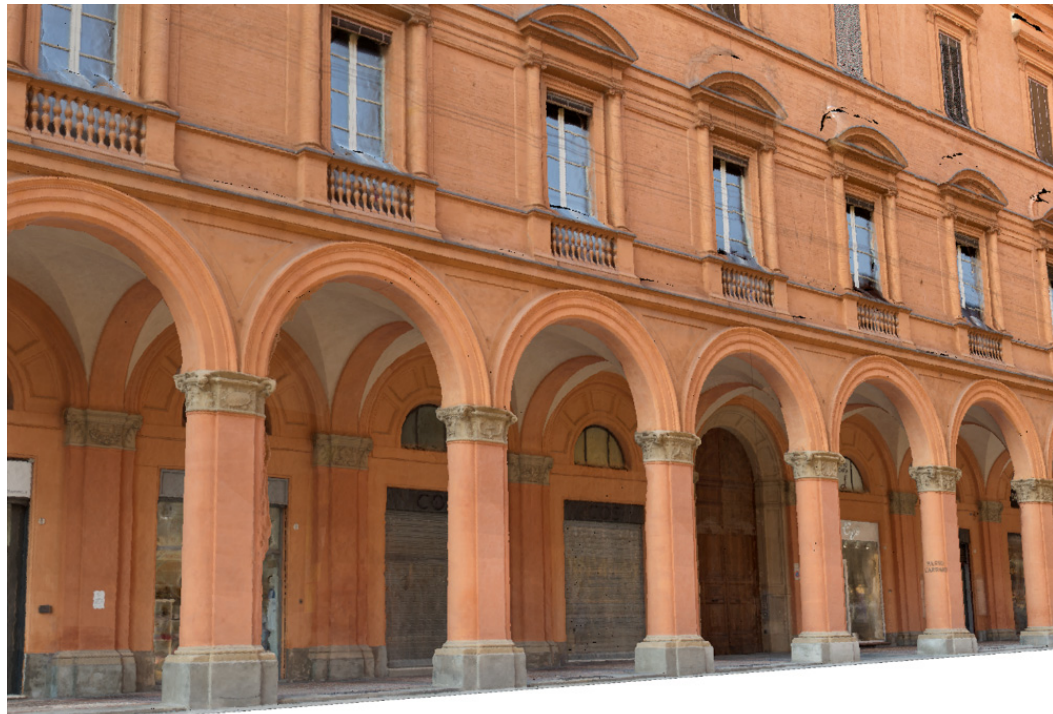
Figure 14. Example of dense 3D point cloud of a portico obtained with the presented photogrammetric methodology based on an advanced pre-processing pipeline.